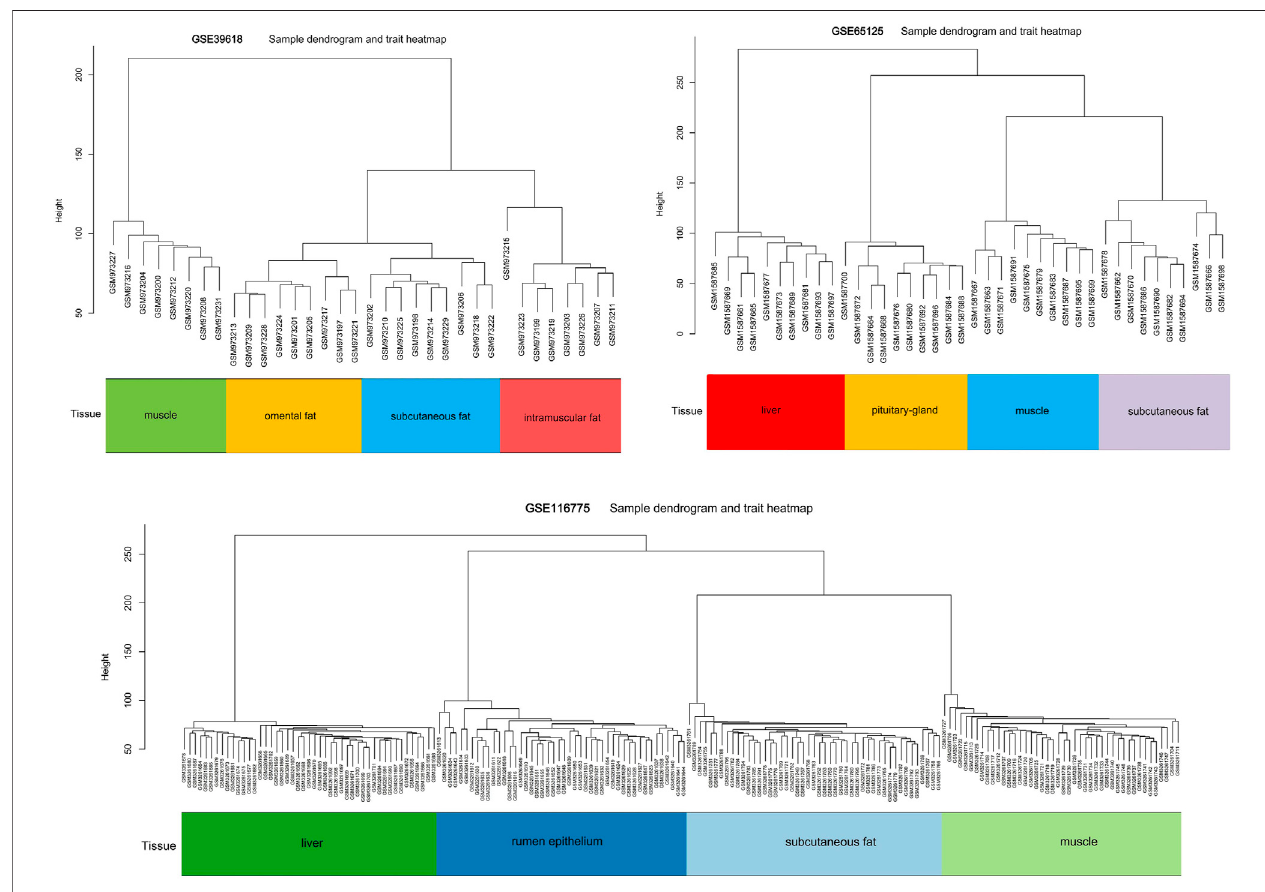
FIGURE 1 | Sample dendrogram and trait heatmap in GSE39618, GSE65125 and GSE116775.